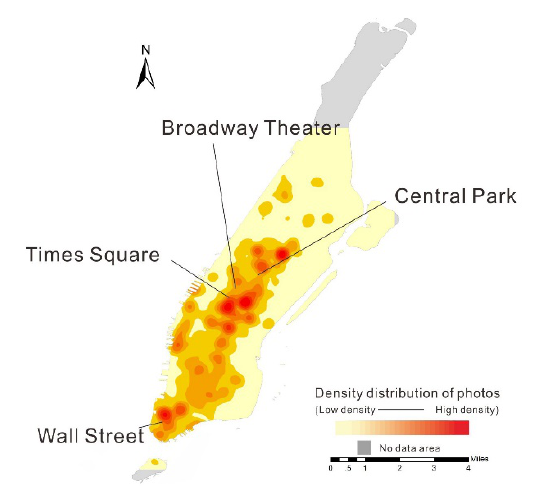
Figure 2 Density distribution of photos at Manhattan Hence, according to the cumulative proportion and the eigenvector, emotion score was defined by the following Eq. 3’.